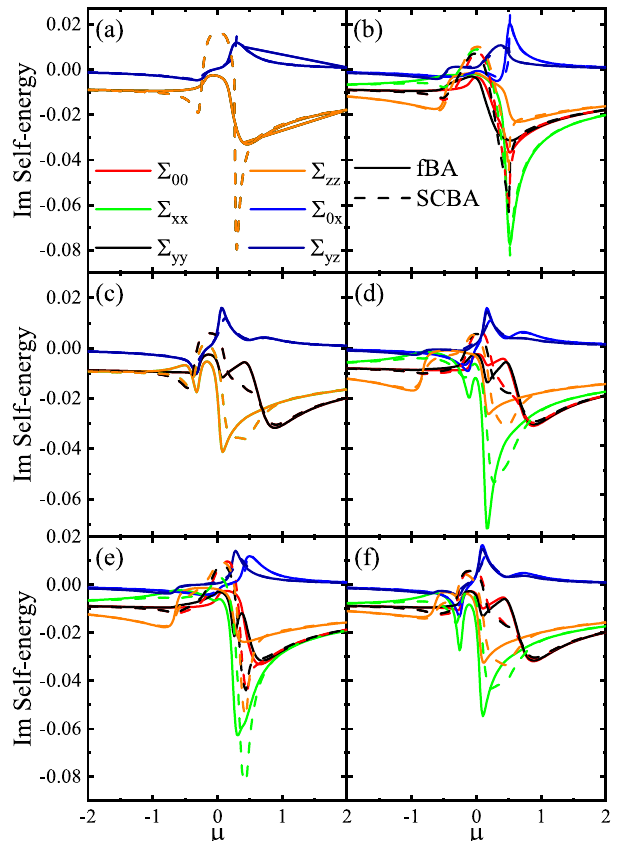
Figure 4. Imaginary part of the self-energies as a function of the µ in the fBA and SCBA methods for ( a ) M = 0 and V = 0 , ( b ) M = 0.4 and V = 0 , ( c ) M = 0 and V = 0.4 , ( d ) M = 0.4 and V = 0.4 , ( e ) M > V with M = 0.4 and V = 0.2 , and ( f ) M < V with M = 0.2 and V = 0.4 . Here (cid:31) = 0.2 , γ b = 0.2 , s = 1 , and r = 1 .